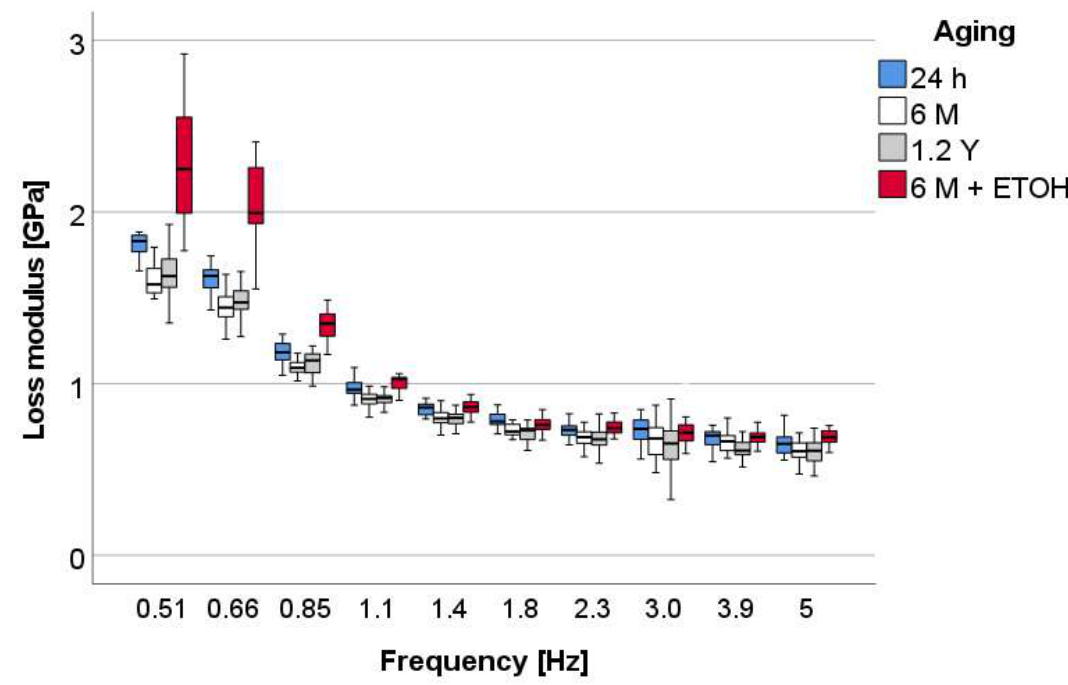
Figure 7. Loss modulus (E″) as a function of frequency and aging method, exemplified for the material OC.